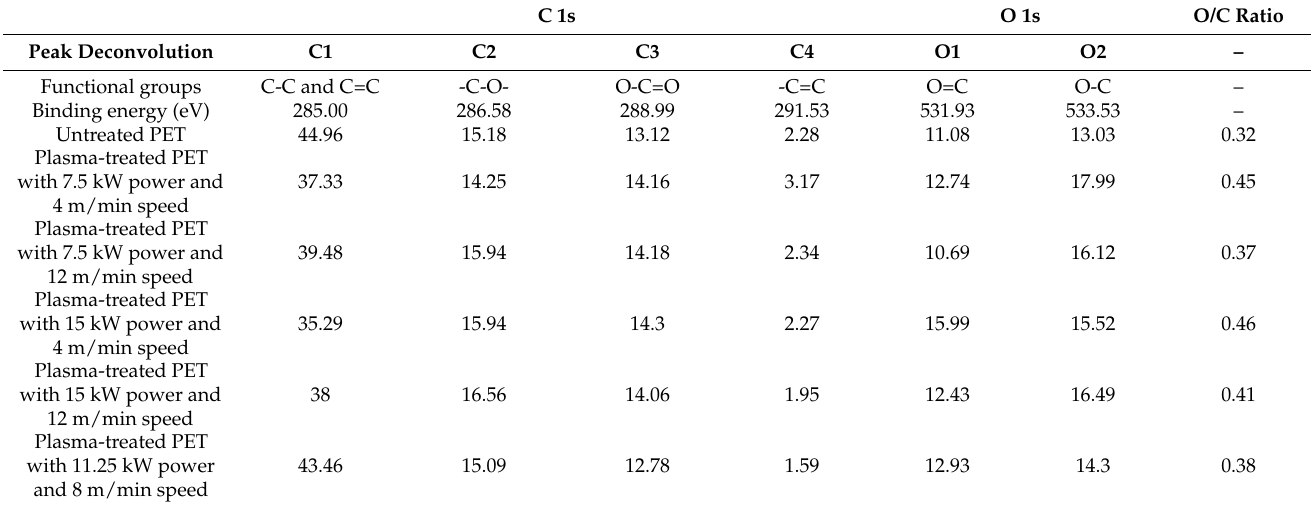
Table 4. Relative composition (in percentages) of the di ff erent chemical groups detected with the deconvolution of the C 1s and O 1s spectra for the plasma-treated samples.